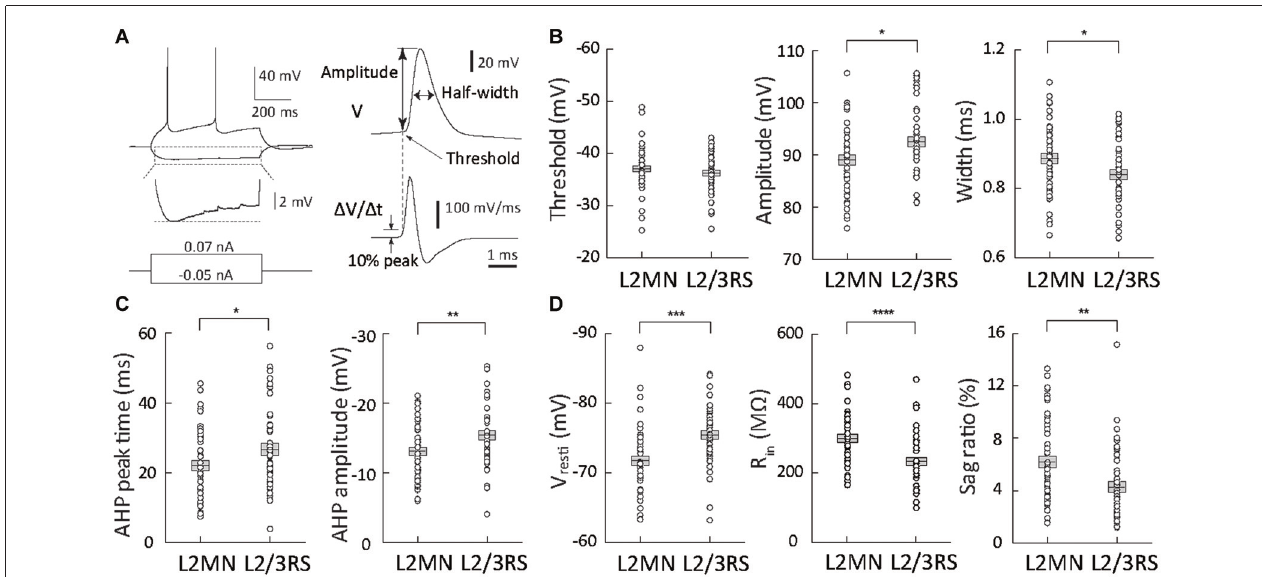
FIGURE 3 | Comparison of action potential (AP) waveform parameters and passive membrane properties between L2MNs and L2/3RS neurons. (A) Measurement method of waveform parameters. Left: responses to injections of a − 50 pA hyperpolarized current and a 70 pA depolarizing current that was the minimum current evoking an AP. The hyperpolarization response marked by the dotted box is further shown in an enlarged voltage scale to illustrate the sag potential. Right: the waveform of the first of the evoked APs was analyzed; the upper trace is the original recording (V) and the lower trace is the temporal differentiation of the upper trace ( ∆ V/ ∆ t). The time when the differentiated signal reached 10% peak value was used to measure the voltage value in the upper trace and the value was taken as AP threshold; the value was also used as “baseline” for measurement of AP amplitude. (B) AP waveform parameter values of L2MNs and L2/3RS neurons. Left: threshold. Middle: amplitude. Right: half-width. (C) After-hyperpolarization potential (AHP) parameter values of L2MNs and L2/3RS neurons. Left: AHP peak time. Right: AHP amplitude. (D) Passive properties of L2MNs and L2/3RS neurons. Left: Resting membrane potentials (V rest ). Middle: Input resistances (R in ). Right: Sag ratio. Error bar = standard error of the mean (SEM); ∗ p < 0.05; ∗∗ p < 0.01; ∗∗∗ p ≤ 0.001; ∗∗∗∗ p ≤